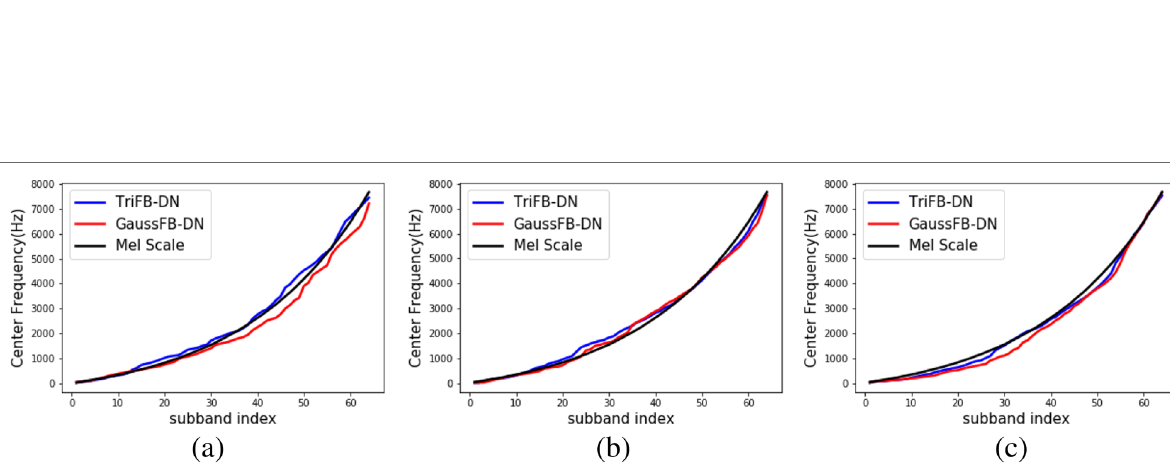
Fig. 6 Comparison of frequency centers learned from network with the Mel scale. a Audio separation task on MIR-1K dataset. b Audio classification task on DCASE2016 dataset. c Audio classification task on LITIS ROUEN